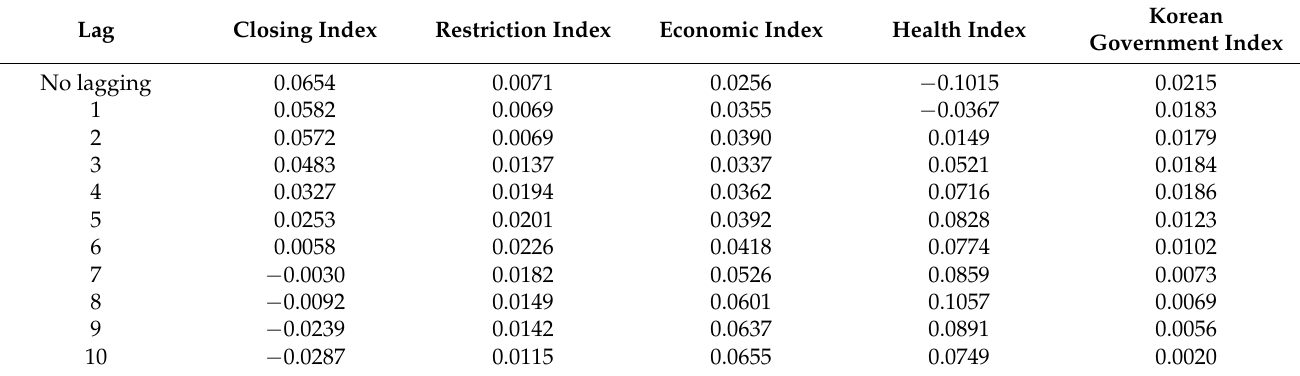
Table 8. Domestic Coefficients from Multiple Indices